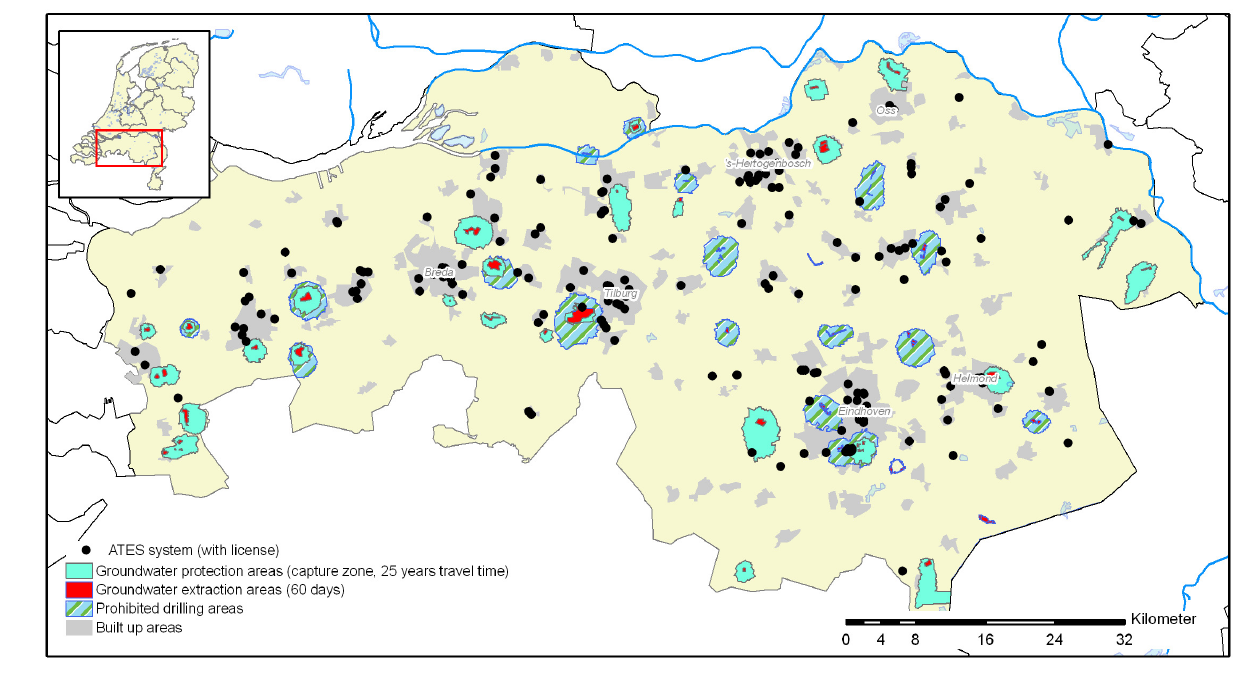
Fig. 2. Map showing the locations of aquifer thermal energy storage (ATES) systems and groundwater protection zones for public supply well fields in the province of Noord-Brabant, the Netherlands. ATES data were sourced from provincial authorities; groundwater protection zones data are courtesy of the National Institute for Public Health and the